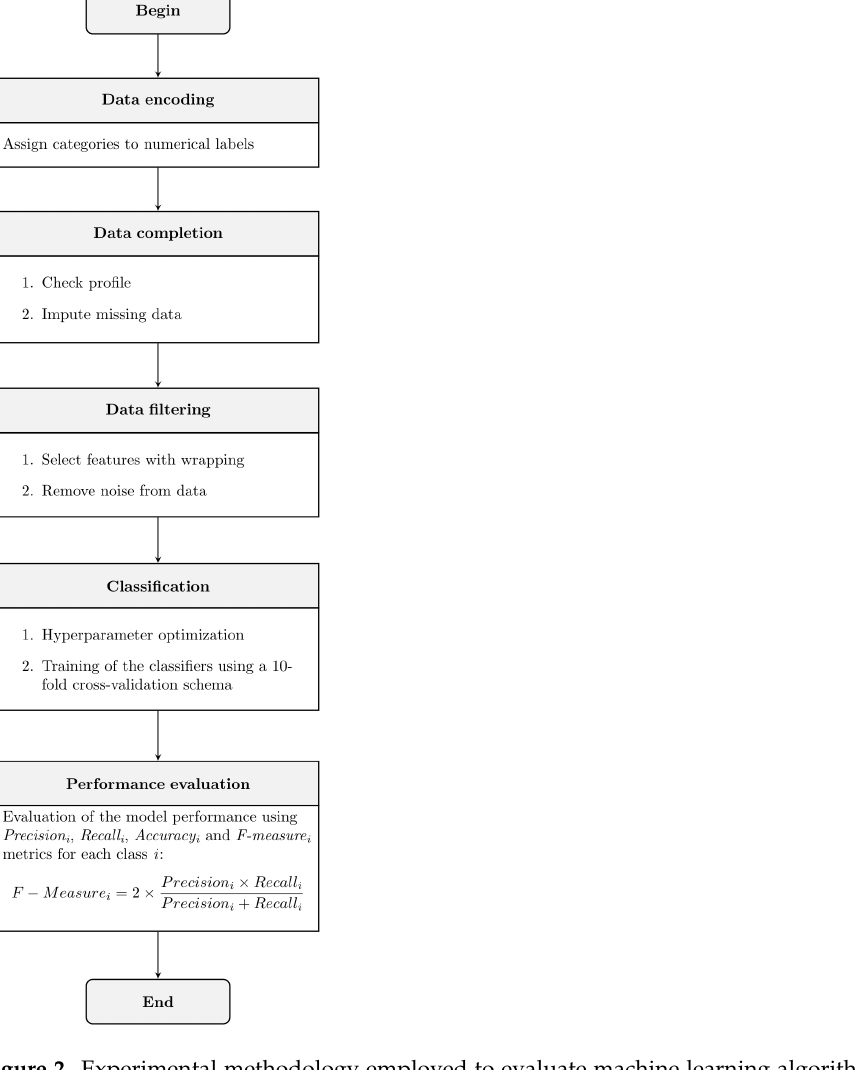
Figure 2. Experimental methodology employed to evaluate machine learning algorithms for the proposed